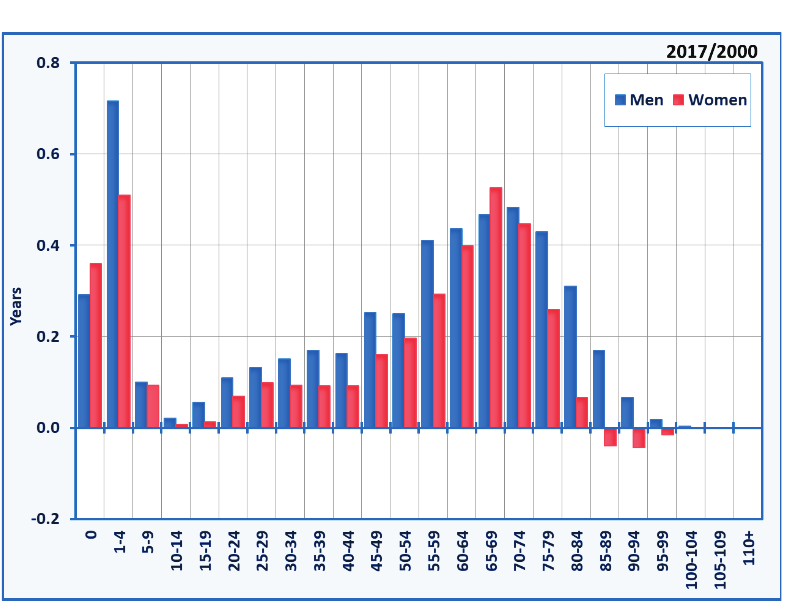
Figure 18. Contribution of age groups to the increase in life expectancy in Azerbaijan between 2000 and 2017. Source: author’s